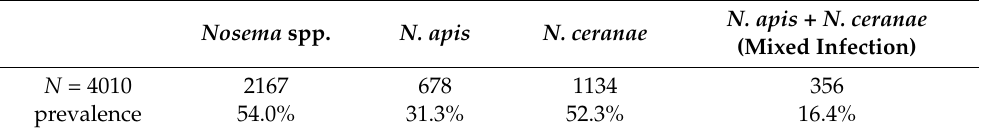
Table 1. Overall incidence and prevalence of Nosema spp.